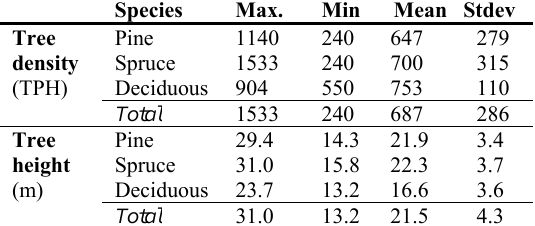
Table 1. The variation of different tree attributes measured in field plots (n = 49) per species class and total. Max, Min, Stdev, and TPH refer to maximum, minimum, standard deviation, and trees per hectare, respectively.